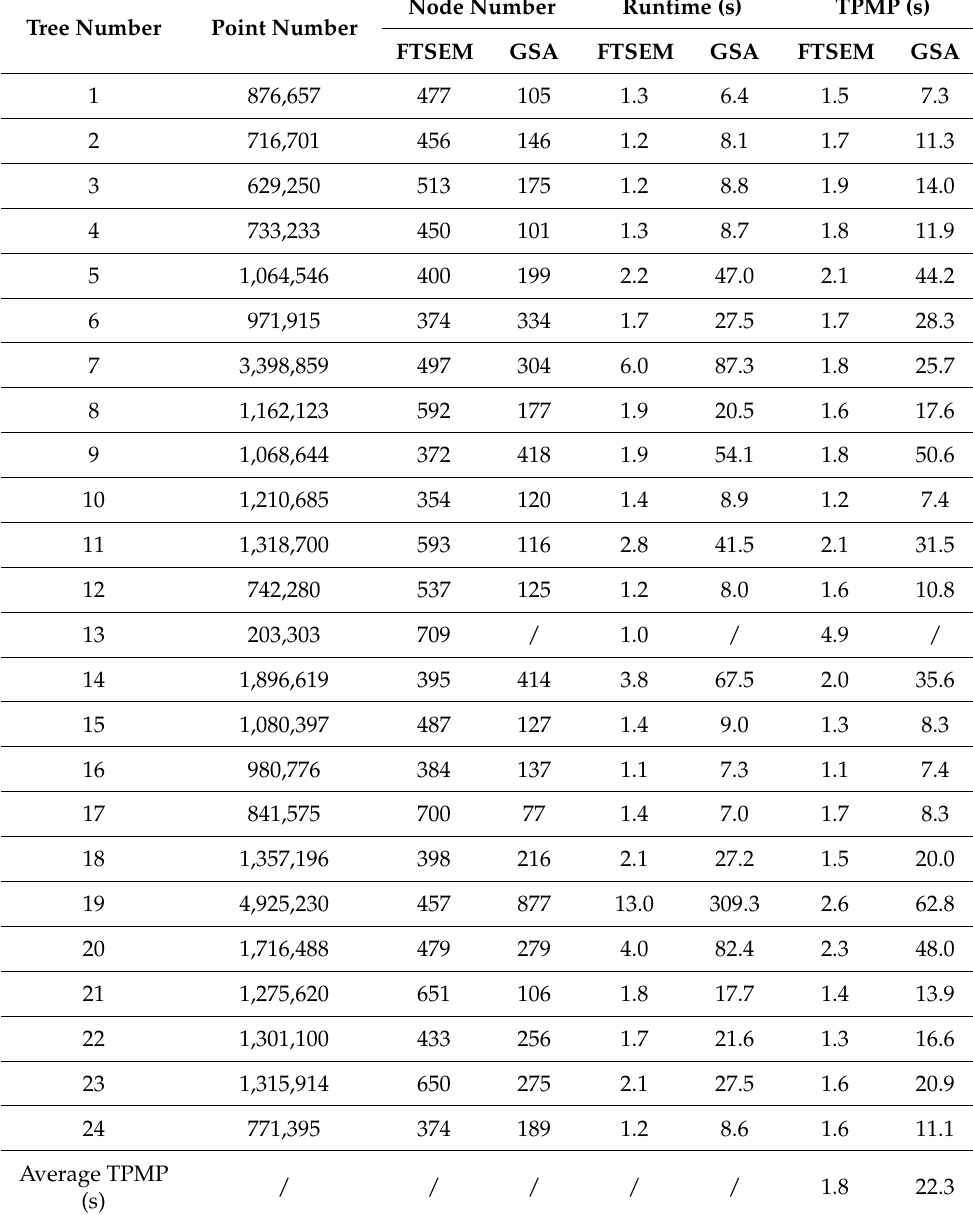
Table 2. The information on twenty-four tree skeletons using FTSEM and GSA. Tree